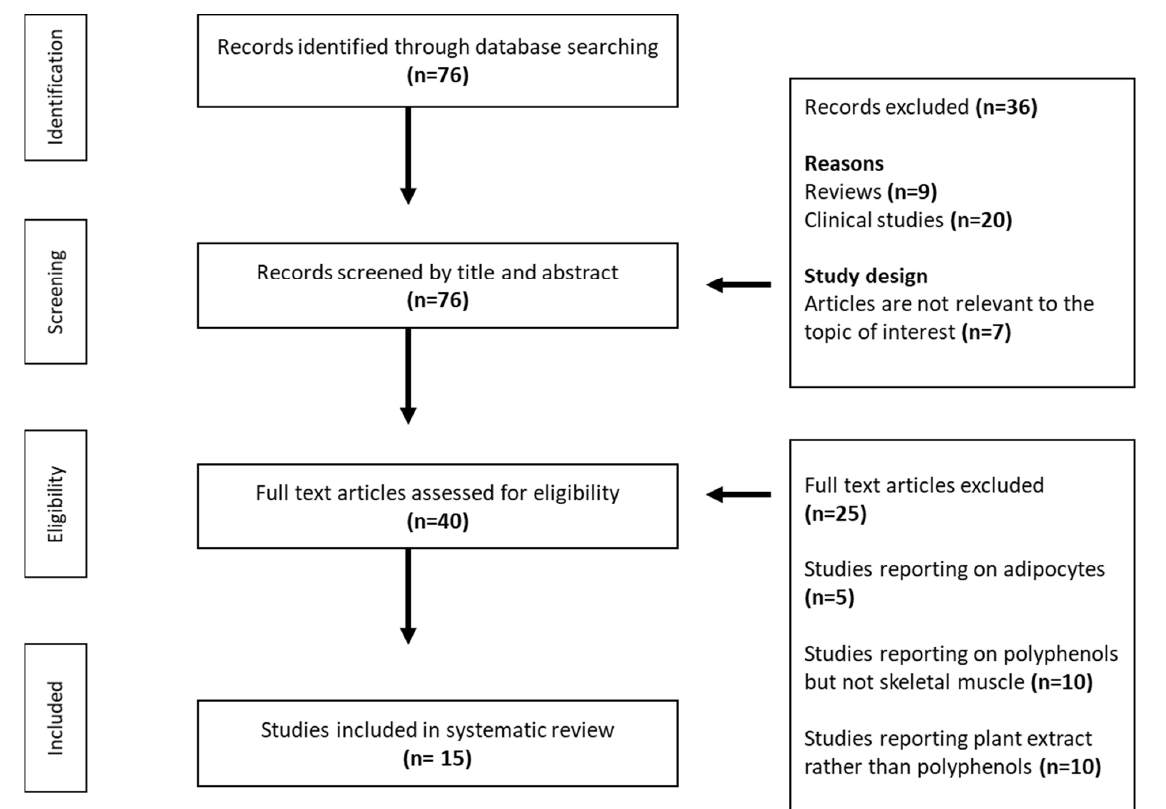
Figure 1. Flow chart representing the study selection procedure. Table 1. A summary of the in vitro studies reporting on the impact of polyphenols on mitochondrial bioenergetics and metabolic function within the skeletal